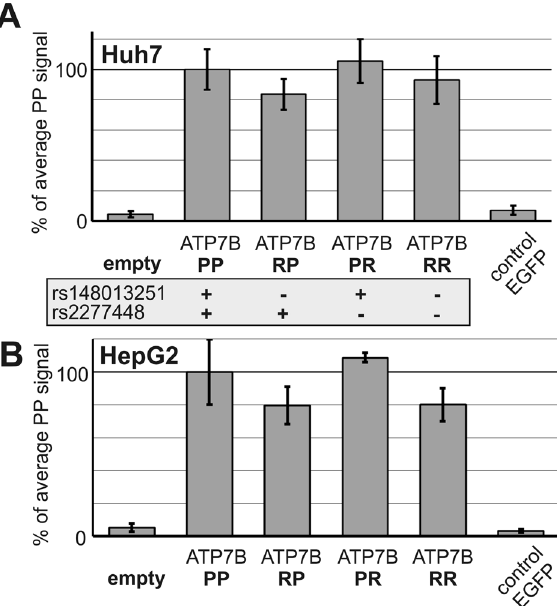
Figure 3. Promoter activity of different polymorphic promoters. The ATP7B promoter was cloned into a pGL4.10 firefly luciferase reporter. Expression of the luciferase reporter constructs PP, RP, PR, RR (polymorphic genotypes are indicated in the grey box) was tested in Huh7 and HepG2 liver cells by co-transfection with renilla luciferase standardization vector pGL74. Original pGL4.10 vector without ATP7B promoter was also transfected for control (“empty”). After 48 h, signals of both luciferase proteins were scored using the DualGlo system. Transfection efficiencies ( renilla luciferase activitieswere comparable in all ATP7B promoter constructs (data not shown). Firefly luciferase reporter activity was normalized on renilla luciferase activity. Average values of 6–12 independent experiments normalized to PP are